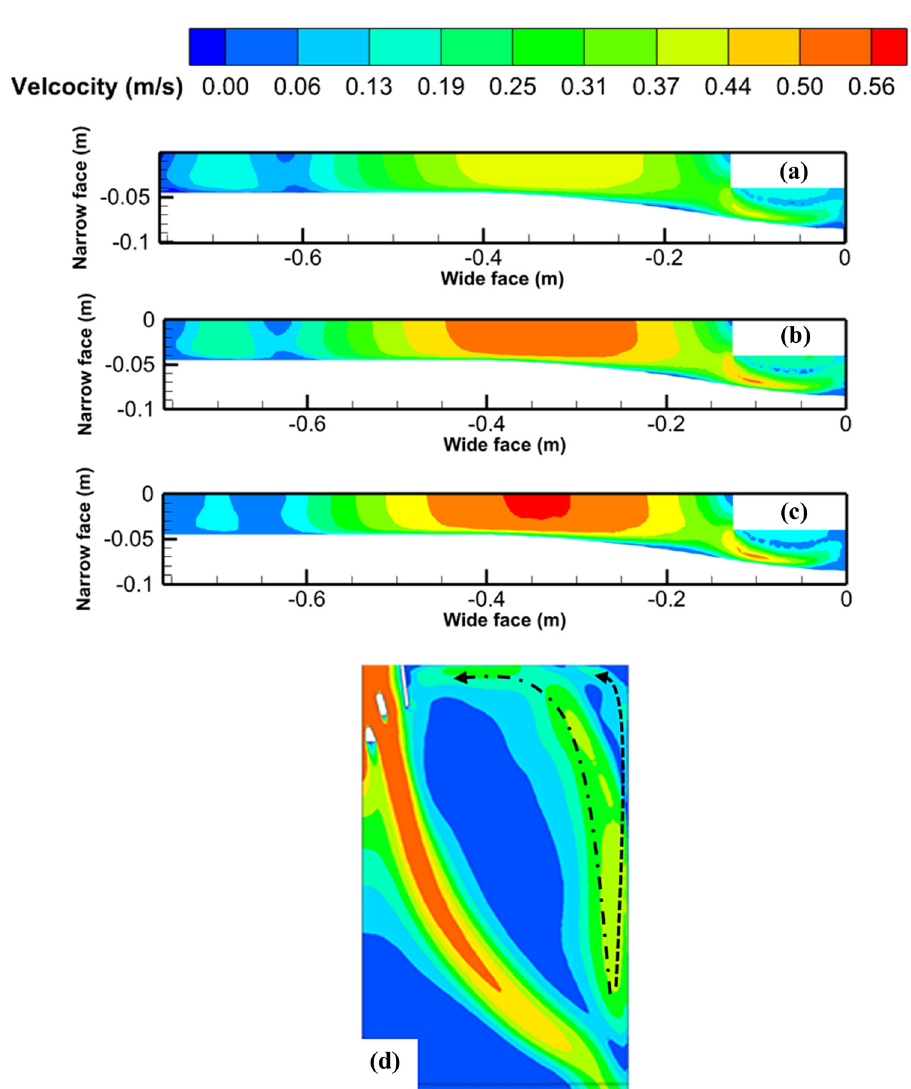
Figure 6: Surface velocity distribution of funnel mold at di ff erent casting speed and image of fl uid fl ow in the funnel mold: ( a ) 4 m · min − 1 , ( b ) 5 m · min − 1 , ( c ) 6 m · min − 1 , and ( d ) image of di ff erent paths fl owing